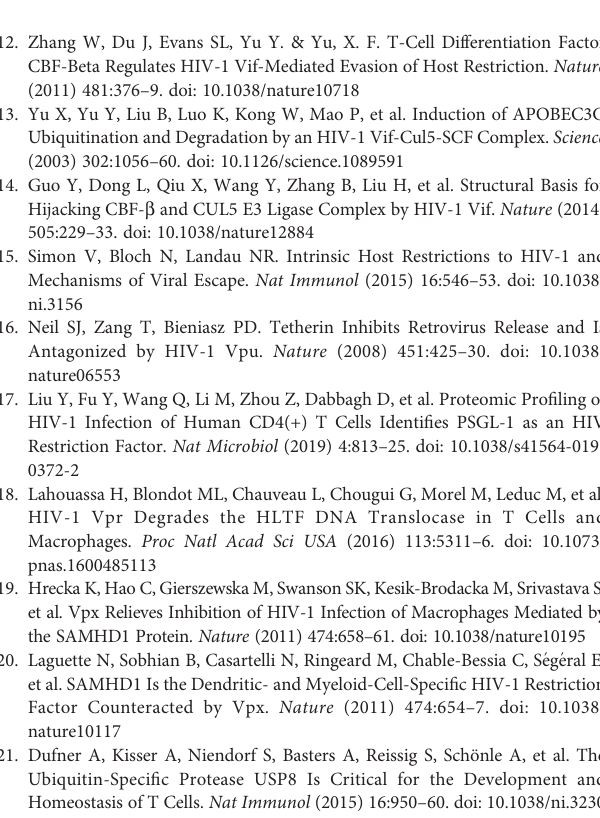
precipitated samples were analyzed by immunoblotting with the corresponding antibodies. (D) A3G ubiquitination was measured by ImageJ2X; A3G mock was set to 100%. Means and standard deviations are from three independent experiments. The statistical signi fi cance analyses were performed using two-tailed unpaired t- tests (NS, not signi fi cant; ***p<0.001). Supplementary Figure 5 | (A) Model showing how HIV-1 Vpr assembles E3 ubiquitin ligase complexes to target HLTF protein polyubiquitination and degradation. (B) Model showing how HIV-1 Vpu assembles E3 ubiquitin ligase complexes to target BST-2 protein polyubiquitination and degradation. (C) Model showing how HIV-2/SIV Vpx assembles E3 ubiquitin ligase complexes to target SAMHD1 protein polyubiquitination and degradation. (D) Screening 32 USPs function on inhibiting Vpr-mediated HLTF degradation. HEK293T cells were transfected with HLTF-HA and Vpr-HA or its empty vector in the presence of 32 USPs. Cells were harvested 48 h after transfection; protein expression in the cell lysates was analyzed by immunoblotting. Quanti fi cation of HLTF expression was analyzed by ImageJ2X. HLTF expression alone was normalized to 100%. (E) Screening 32 USPs function on inhibiting Vpu-mediated BST2 degradation. Quanti fi cation of BST2 expression was analyzed by ImageJ2X. BST2 expression alone was normalized to 100%. (F) Screening 32 USPs function on inhibiting Vpx- mediated SAMHD1 degradation. Quanti fi cation of SAMHD1 expression was analyzed by ImageJ2X. SAMHD1 expression alone was normalized to 100%. (G) USP8 does not inhibit HIV-1 Vpr-induced degradation of HLTF. HEK293T cells were transfected with expression vector as indicated. Proteins in the cell lysates were immunoblotted with the corresponding antibodies. The relative expression of HLTF was analyzed by ImageJ2X. HLTF expression alone was set to 100%. (H) USP8 does not inhibit HIV-1 Vpu-induced BST-2 degradation. (I, J) USP8 does not inhibit HIV-2/SIV Vpx-induced SAMHD1 degradation. (K, L) Virus infectivity was assessed using TZM-BL indicator cells. shCON virus infectivity was set as 100%. Results from D-J are representative of n=3 independent experiments. Means and standard deviations are from three independent experiments. The statistical signi fi cance analyses were performed using two-tailed unpaired t-tests (NS, not signi fi cant; **p < 0.01; ***p < 0.001; ****p <